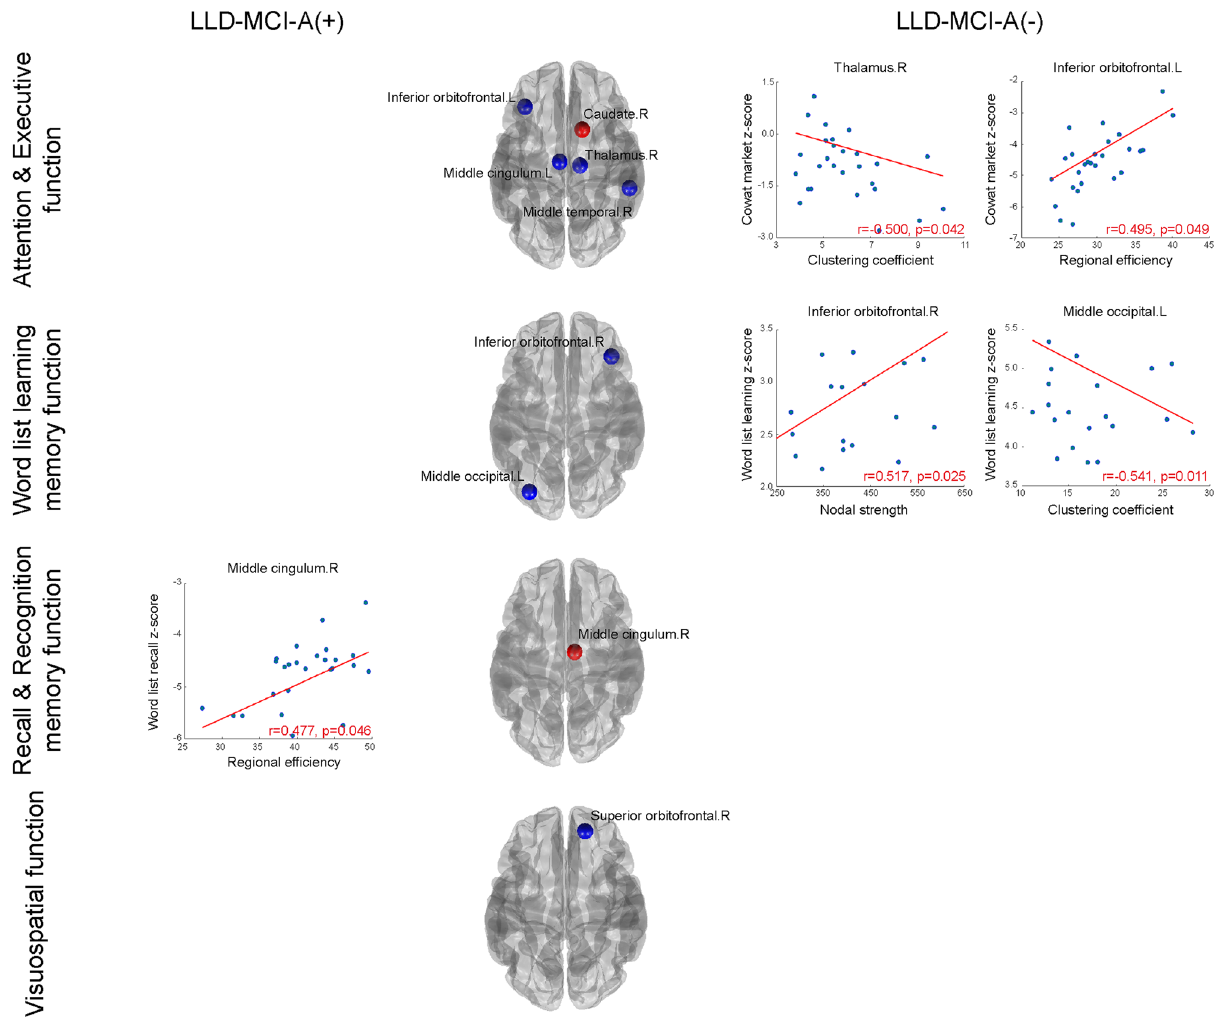
Figure 2. Correlations between the nodal measures and cognitive domains (z-score). Left and right columns show scatter plots of the cognitive domains (z-score) over network measures in the LLD-MCI-A(+) group (leftmost column) and LLD-MCI-A(−) group (rightmost column). Values of the cognitive domains were adjusted, controlling for age, gender, and education level. Lines represent their fitting lines. We denoted partial correlation coefficients and their P-values, controlling for age, gender, and education level. The middle column shows the brain regions associated with significant correlation results, where blue circles represent results from the LLD-MCI-A(−) group and red circles represent results from the LLD-MCI-A(+) group,